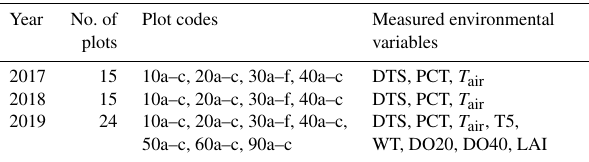
Table 1. The methane (CH 4 ) flux sample plot set-up and measured variables at Lompolojänkkä. DTS: distance to stream; PCT: plant community type; T air : air temperature; T5: peat temperature at 5cm depth below the moss surface; WT: water table; DO20 and DO40: dissolved oxygen concentration at 20 and 40cm below the peat sur- face respectively; LAI: leaf area